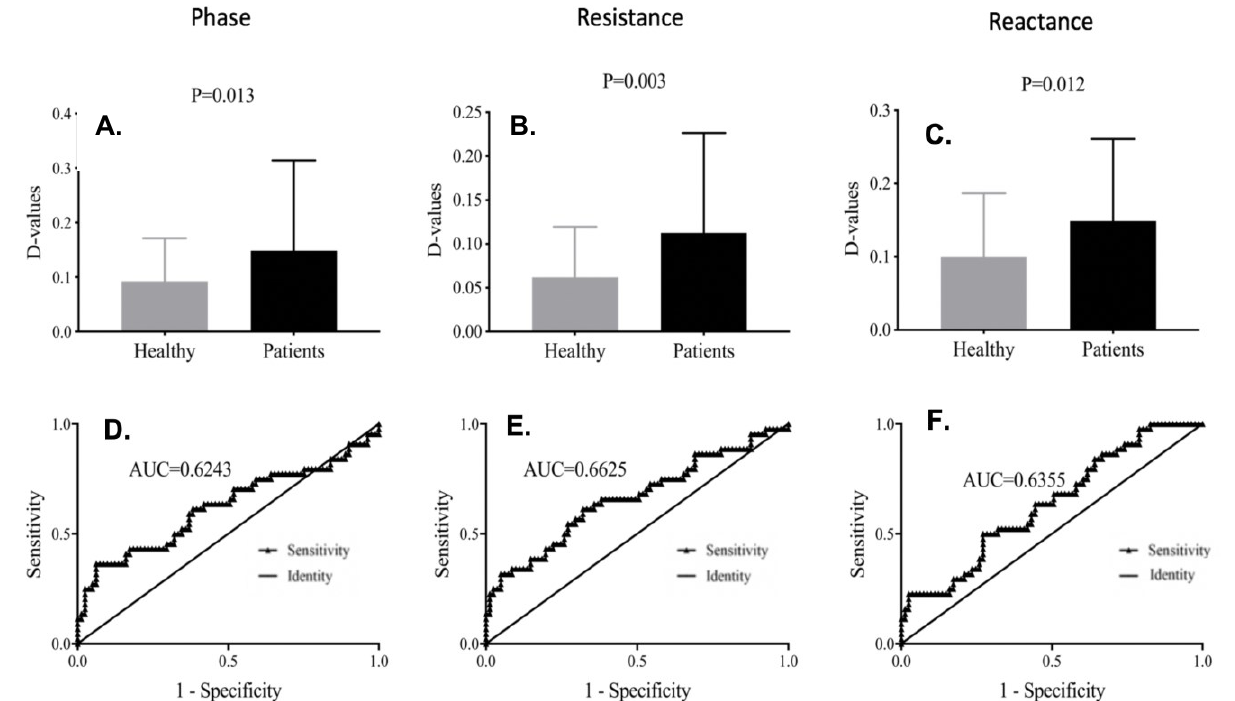
Figure 4. A, B, C. Relative differences in 100 kHz values (absolute value (right-left difference /right-left average)) for low back pain patients versus healthy controls. D, E, F. ROC plots for these same values. The D-value is equal to the side-to-side difference divided by the average of both sides. While still not a strong discriminator, this approach is